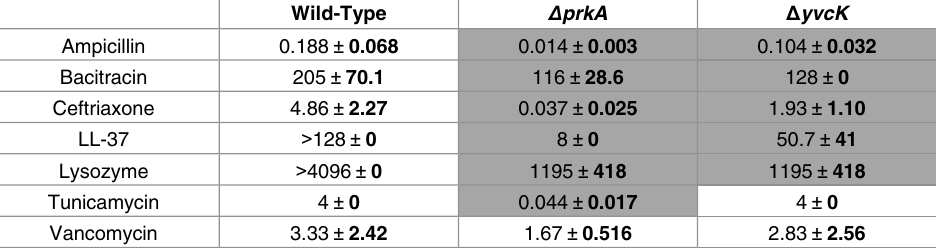
Table 1. Minimum inhibitory concentrations of cell wall targeting agents in BHI. Values are mean min- imum inhibitoryconcentrations and standard deviationsin μ g/mL. Values were determinedby five or more biologicalreplicates of serial 2-fold dilutionsup or down from 1 μ g/mL. Shaded boxes are statistically signifi- cant compared to wild-type (Student’s T-Test P <